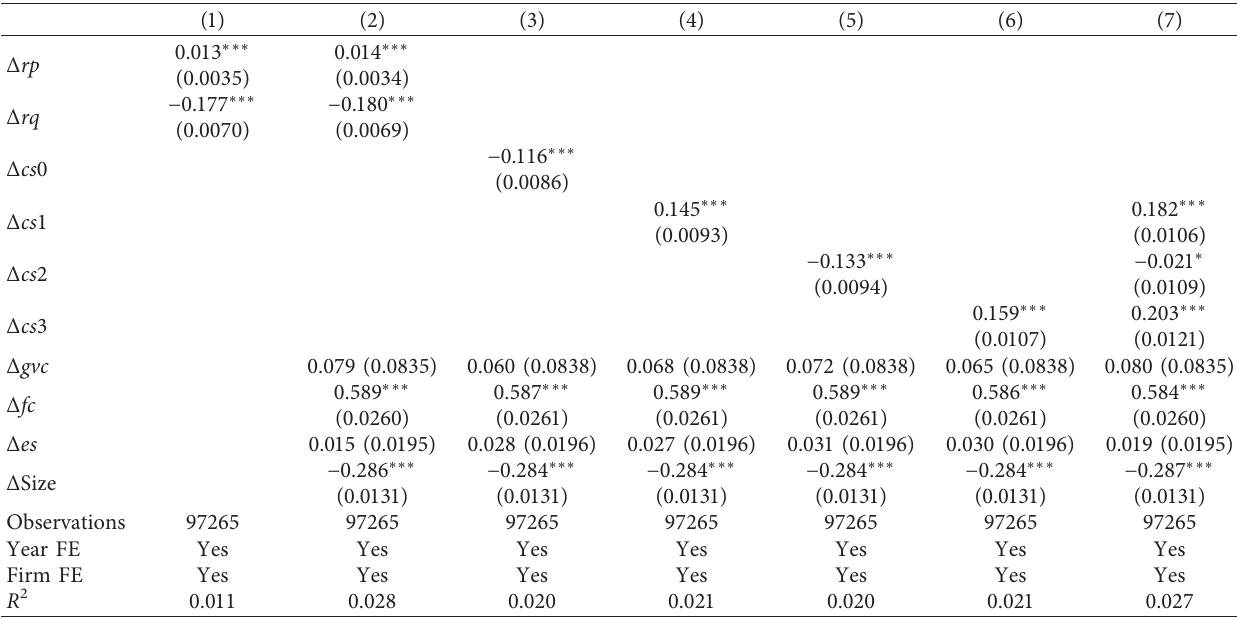
Table 8: Estimation results of the difference